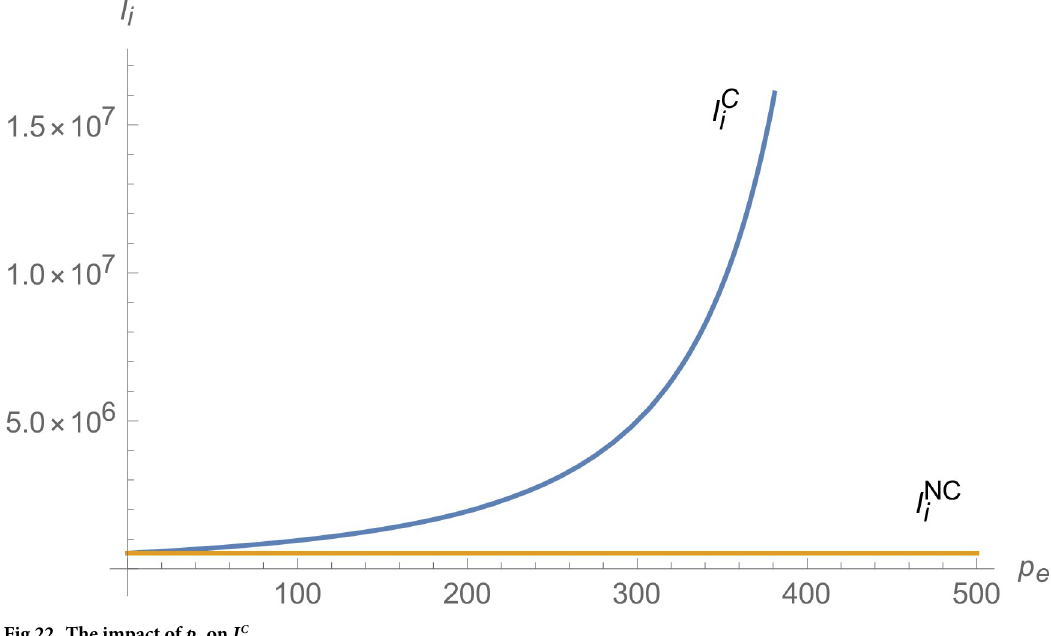
Fig 22. The impact of p